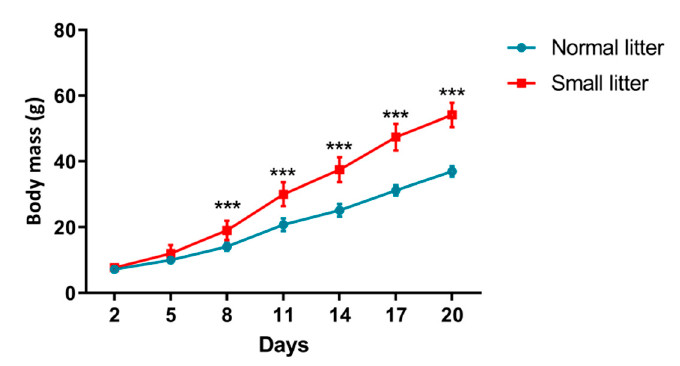
Figure 1. Increase in body mass in animals from normal vs. small litters during the suckling period. Each point represents the mean ± standard deviation. Comparison between masses of animals ( n = 12 animals per group) from small and normal litters by time was done by two-way repeated measures ANOVA followed by Sidak’s post hoc test and the difference is considered significant at p < 0.05. Symbols denote significant difference in masses between normal litter (NL) raised and small litter (SL) raised animals for certain time points (*** p < 0.001).